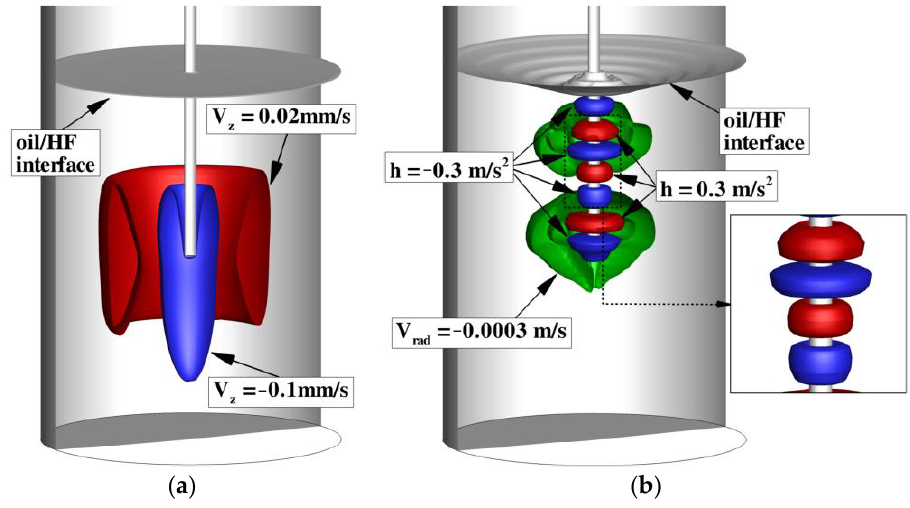
Figure 8. Axial symmetry of the flow structures: ( a ) visualization of isosurfaces of constant axial velocity for the TCN1 case; ( b ) visualization of isosurfaces of constant helicity density for a generic instantaneous 7-vortices configuration of the TCN2 case.